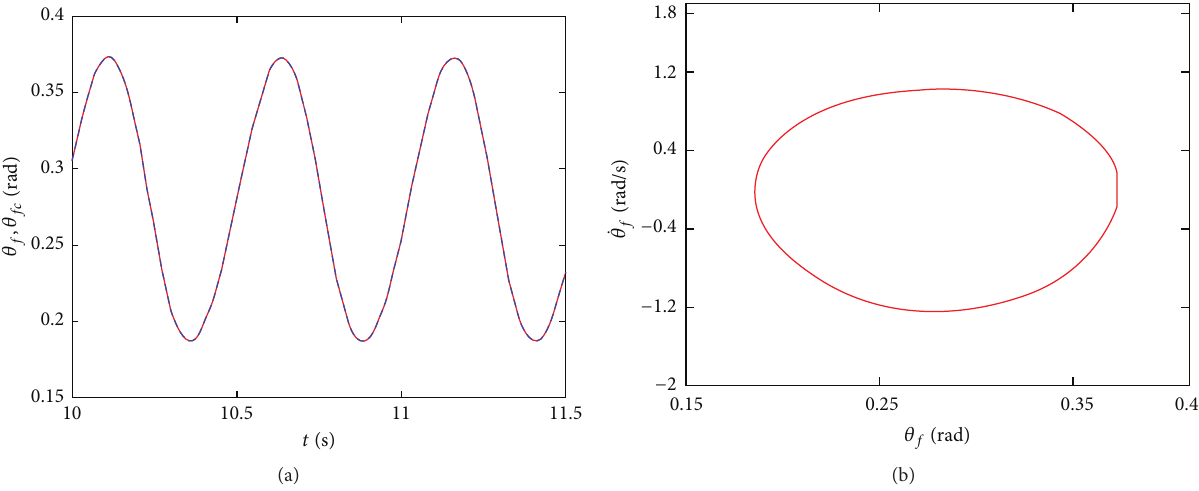
Figure 4: Cam and follower permanent contact when 𝜔 = 12 rad/s: (a) time history of 𝜃 𝑓 (solid line) and 𝜃 𝑓𝑐 (dashed line) and (b) phase